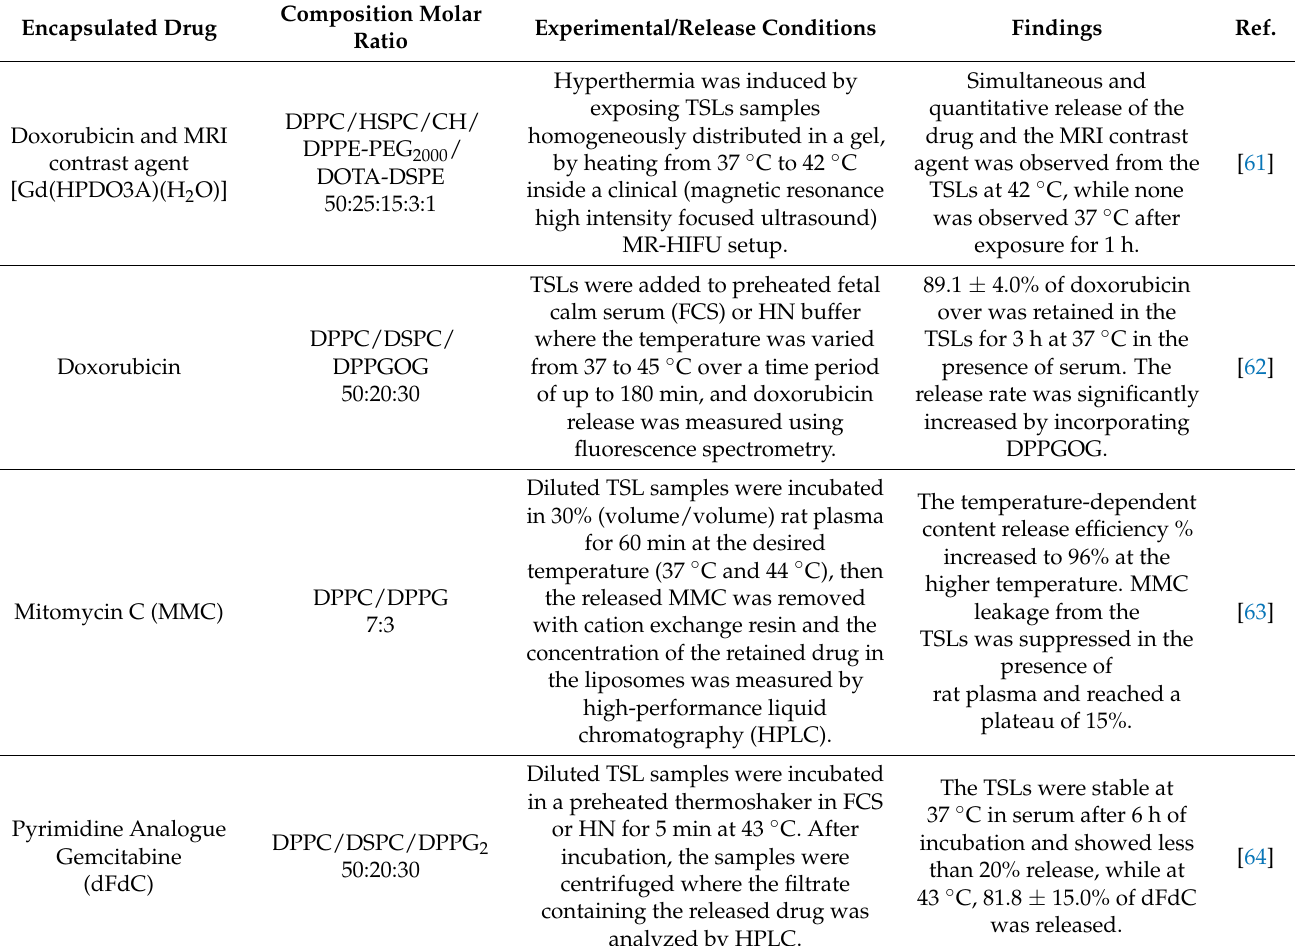
Table 2. Some traditional thermosensitive liposomal systems (TTSLs) and their corresponding transition